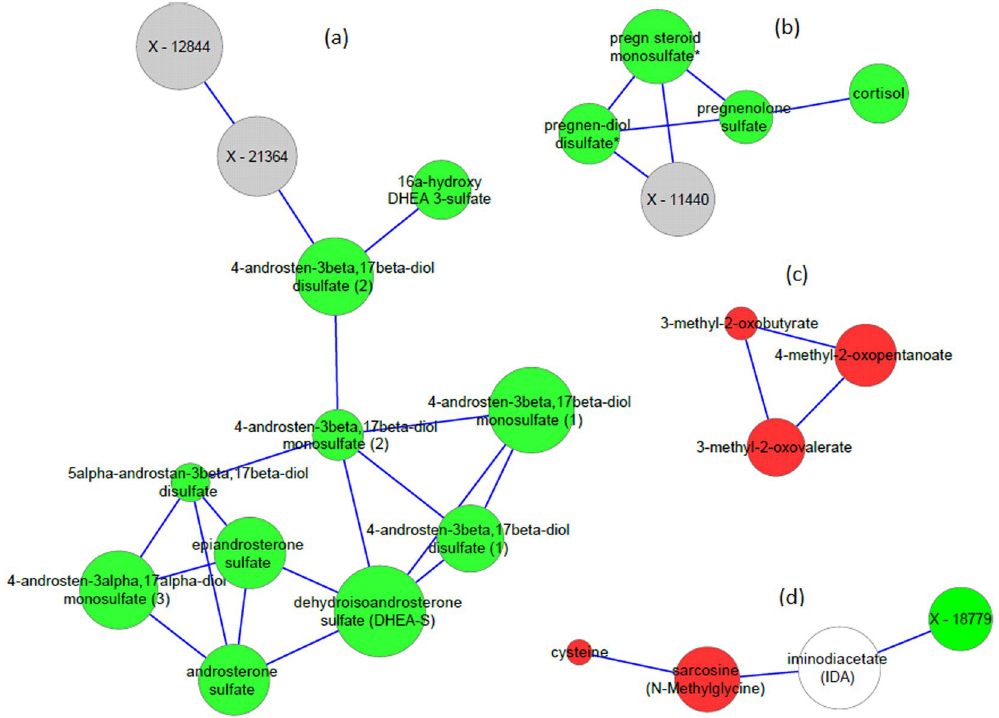
Figure 2. GGM sub-networks of metabolites that have a Bonferroni significant association with RA. Steroids sub-networks ( a , b ), BCAAs sub-network ( c ) and iminodiacetate sub-network ( d ). The size of the node proportional to – (log p value) (larger nodes indicate more significant association to RA). Red color indicates an amino acid, green indicates a lipid, white indicates a xenobiotic and grey indicates an unknown